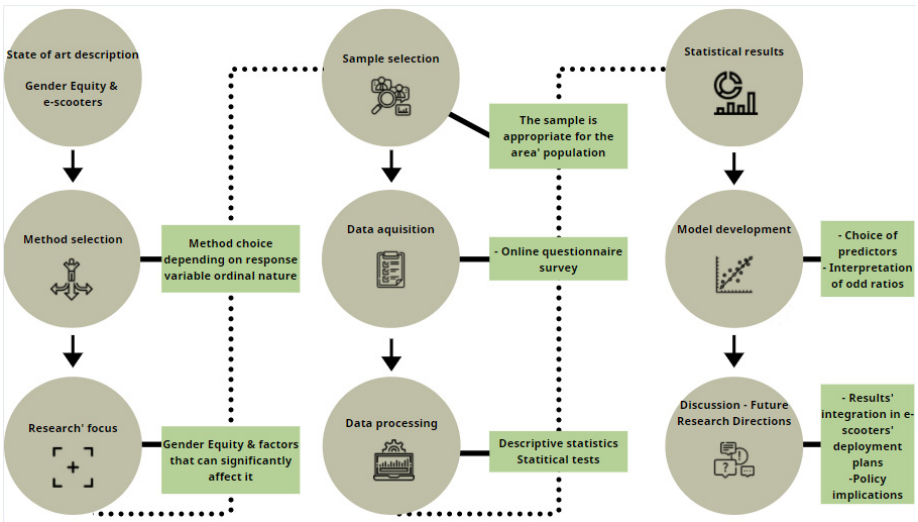
Figure 2. Methodological framework of the present research.